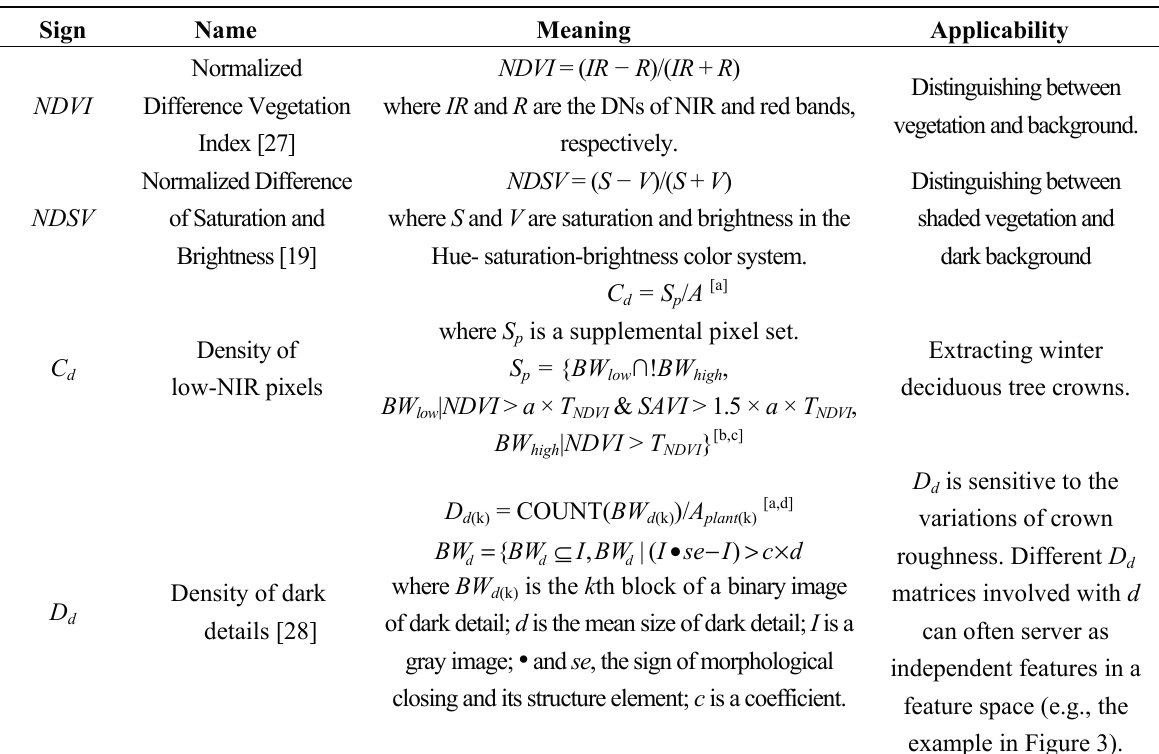
Table 1. Four features for the